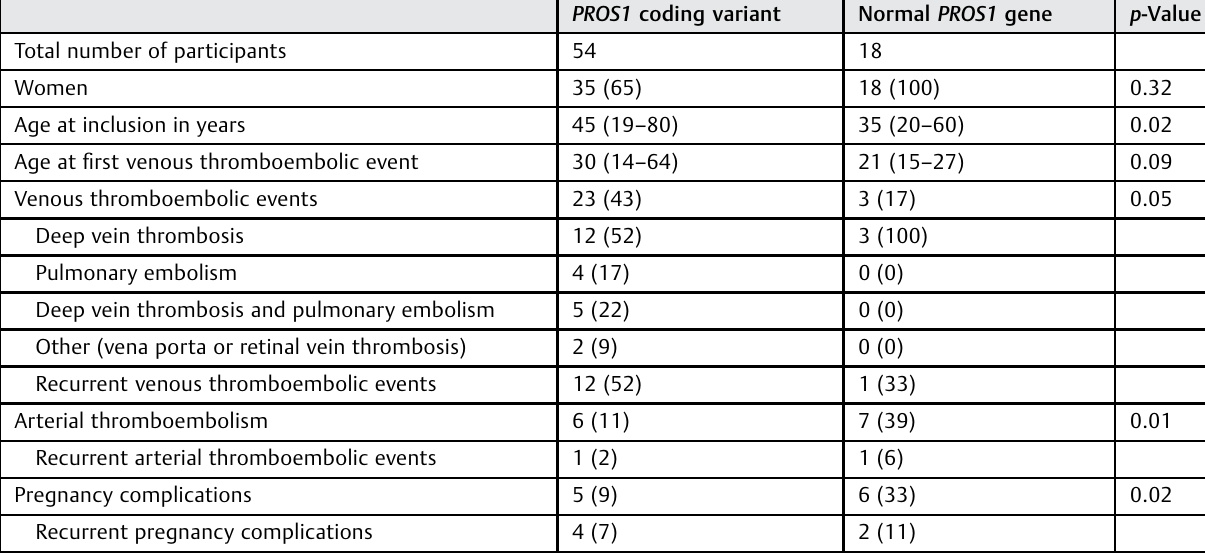
Table 4 Thromboembolic events and pregnancy by variant status ( PROS1 variants class 3 –